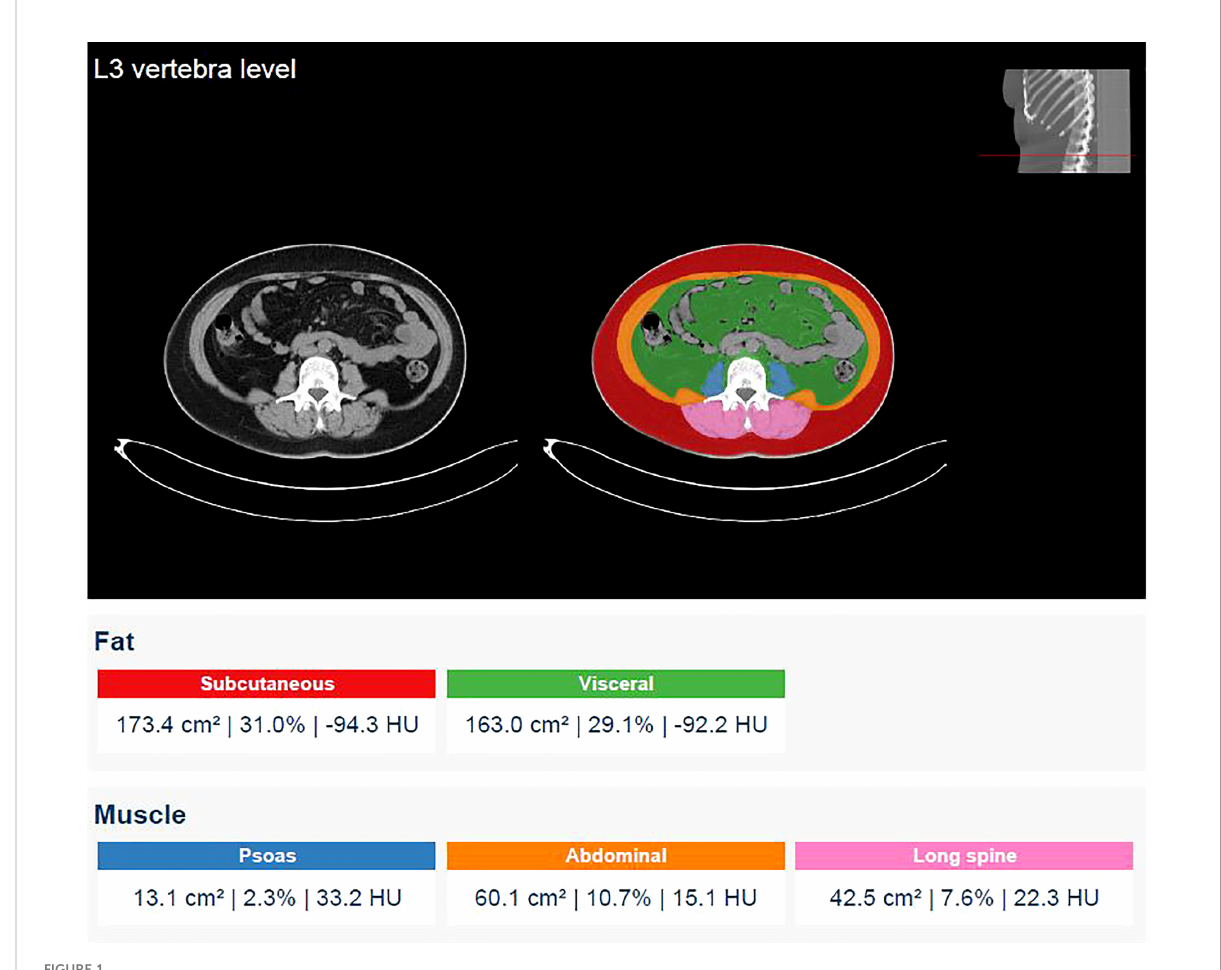
FIGURE 1 Screenshot generated by the software after performing an automatic segmentation at the level of the third lumbar vertebra and report of the measurements of SAT, VAT and SMA carried out. SAT values are indicated in red and VAT values in green. SMA is obtained by summing the areas of the psoas, the abdominal and the long spinal muscles indicated in blue, orange and pink respectively (13.1 + 60.1 + 42.5 = 115.7 cm 2 ). SMI is then calculated as the ratio of SMA to the height squared of the